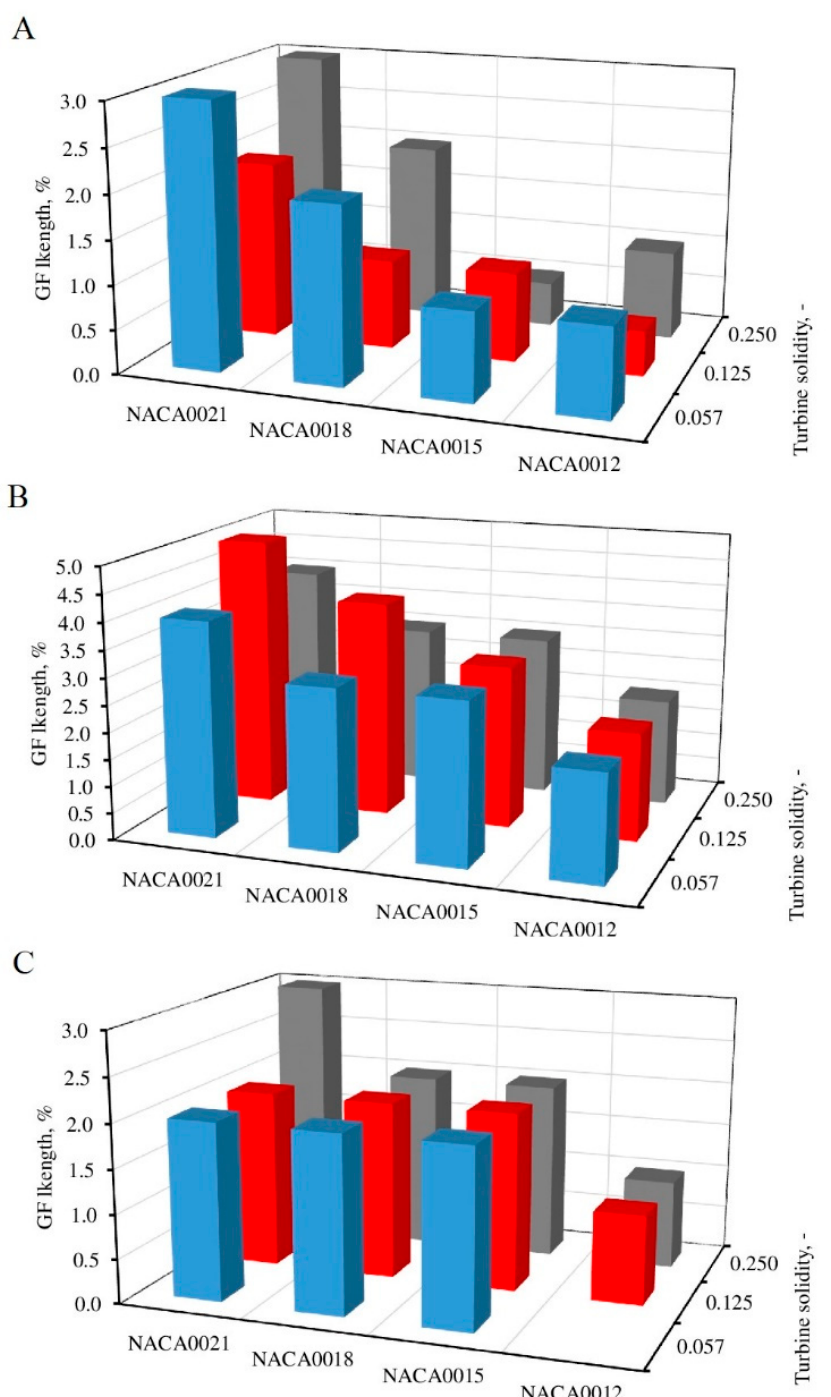
Figure 19. Optimal value of the GFs length for all investigated turbine configurations: ( A ) inward GF, ( B ) outward GF, ( C ) fish tail.